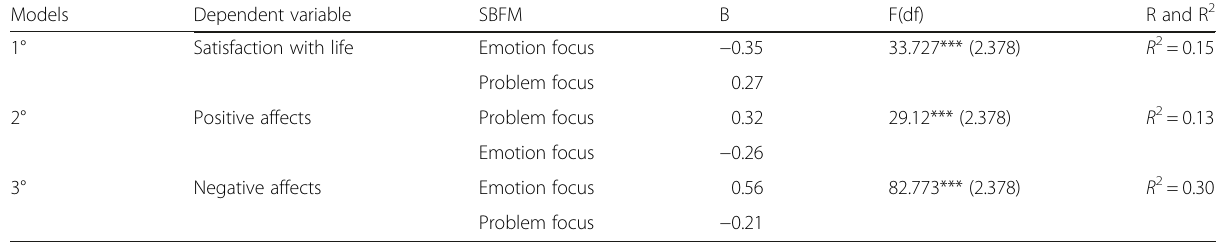
Table 4 Multiple linear regression between coping strategies and subjective well-being